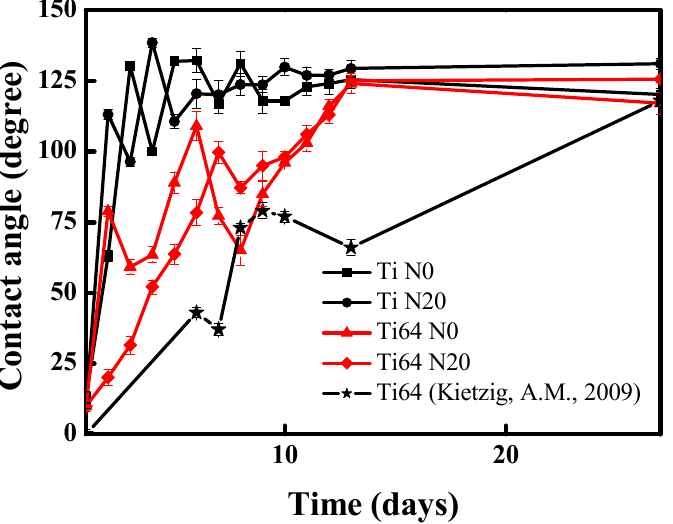
Figure 13. The relationship between the holding time and the measured values of the contact angles for CP-Ti and Ti64 samples treated in an air atmosphere with a laser power 5 W. (cid:70) data in the figure is from [52]